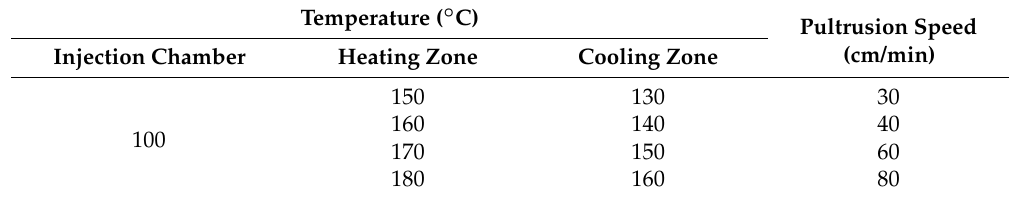
Table 1. The specific process parameters of the thermoplastic reaction injection pultrusion.